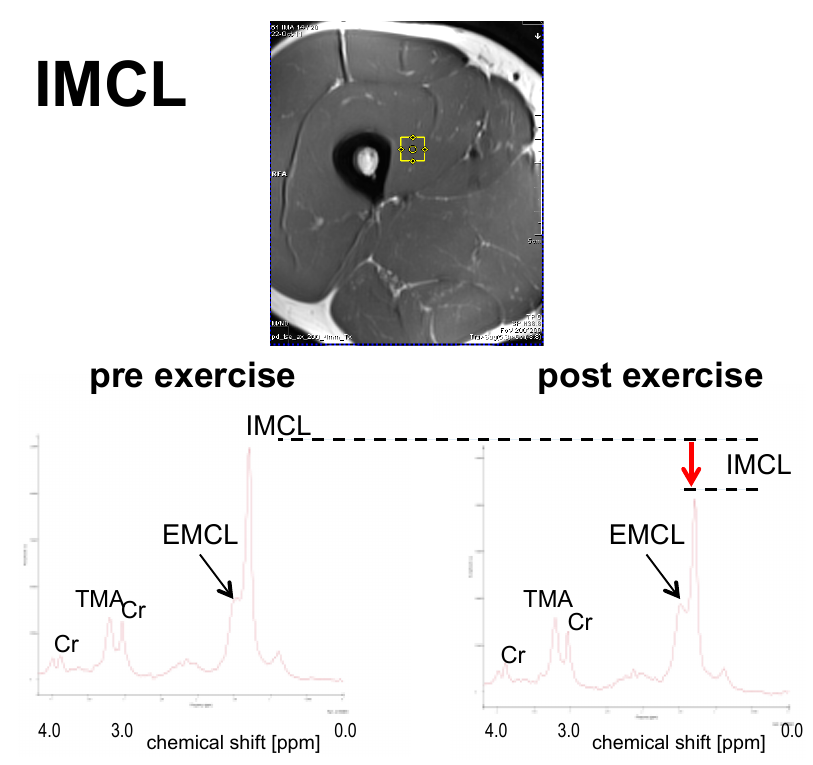
Figure 1. Sample 1 H-MR spectra for the quantification of IMCL obtained from m. vastus intermedius before and after an exercise bout of 2 h: The largest peak in the spectrum originates from the aliphatic methylene groups in the fatty acid chains of IMCL. Direct comparison of the pre- and post-exercise spectra shows that IMCL were consumed in the exercise. Other peaks originate from further protons on the IMCL lipid chains, but also from the partially overlapping spectrum of extramyocellular lipids (EMCL, see e.g., [90] for details), as well as creatines (CH2 at 3.9 ppm and CH3 at 3.0 ppm) and trimethyl-ammonium (TMA) groups from metabolites, like carnitine, or the phosphocholines. (For details of the acquisition methods, see the electronic supplement to [43]; in short: single volume (~1.5 cm 3 ), double spin echo localization, echo time 30 ms, 3T). The spin-echo image above the spectra shows the typical location where the spectra were